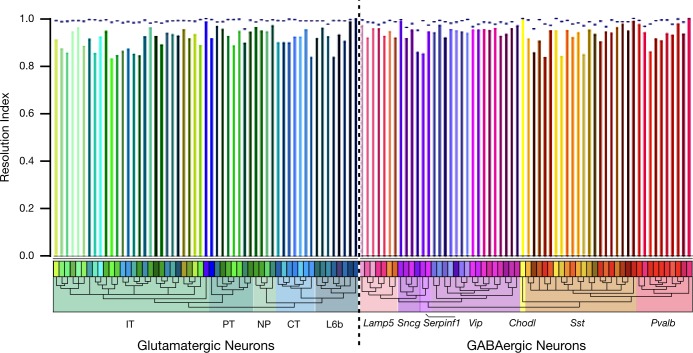
Autoencoder expression clustering performance by neuron type.Results here compare classification based on 6,083 HE genes (dashed line) with results based on 47 NP genes (colored vertical bars). The resolution index (RI), as described in connection with Figure 4, generates a measure of autoencoder clustering agreement with the Tasic 2018 neurotaxonomy. Figure 4D represents resolution index distributions across all glutamatergic and GABAergic neurons represented in the Tasic 2018 dataset. This population is weighted, however, by the Tasic 2018 sampling process and does not represent the actual distribution of neuron types in cortex. As a check for possible anomalies related to this sampling process, we averaged resolution indices separately for each Tasic 2018 neuron type, as shown here. The single-type average resolution indices for both HE and NP gene sets are high across all types (>0.95 for HE and >0.8 for NP), confirming the adequacy of both gene sets in identifying all of the Tasic 2018 neuron types. Interestingly, this metric suggests that clustering performance using the 6,083 HE gene set is slightly worse for GABAergic than for glutamatergic types, while the reverse is true for the 47 NP gene set. Both effects are, however, quite small.